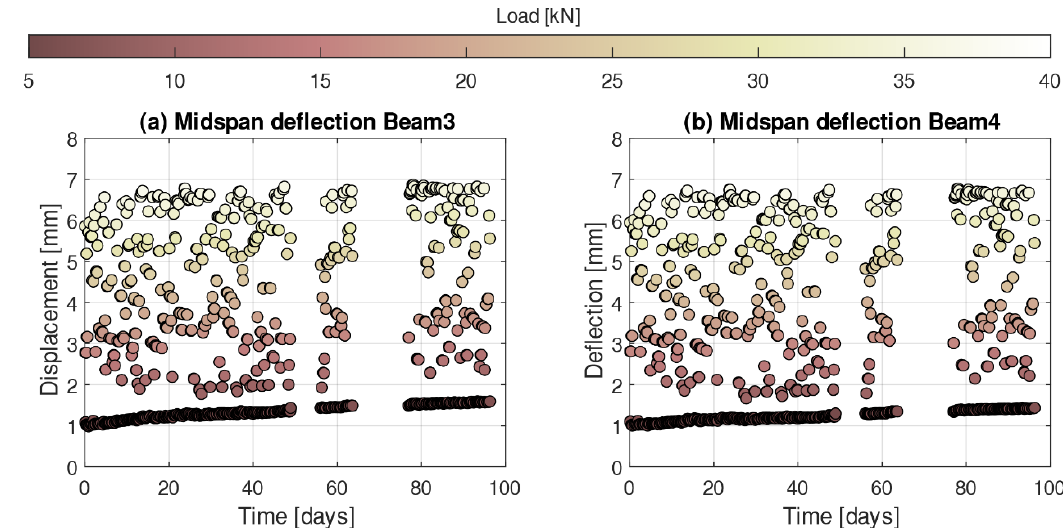
Figure 10. Evolution of the midspan deflection calculated from DOFS strain measurements for ( a ) beam 3 and ( b ) beam 4.